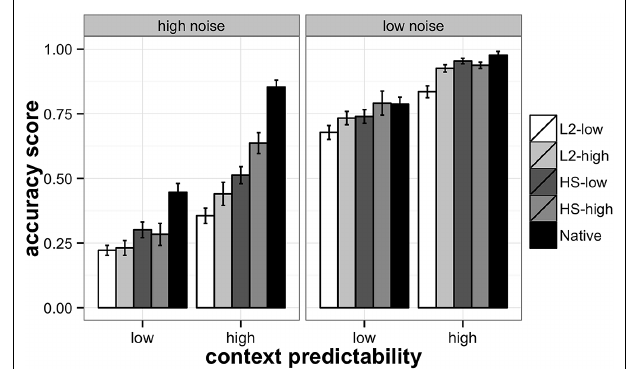
FIGURE 1 | Accuracy scores on SPIN task in heritage, L2, and native participants. Heritage and L2 participants are divided into high- and low-proficiency groups.The left panel represents the high-noise and the right the low-noise conditions. L2-low – low-proficiency L2 learners, L2-high – high-proficiency L2 learners, HS-low – low-proficiency heritage speakers, HS-high – high-proficiency heritage speakers, and Native – native speakers of